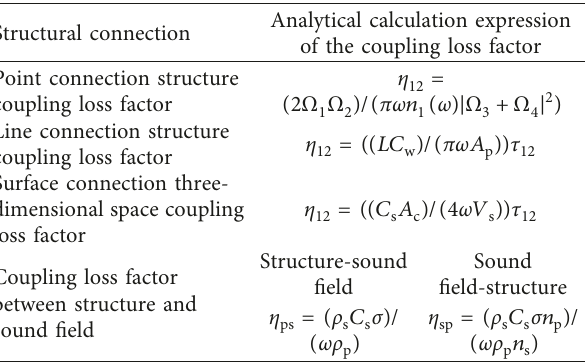
Table 1: Expression of the coupling loss factor.